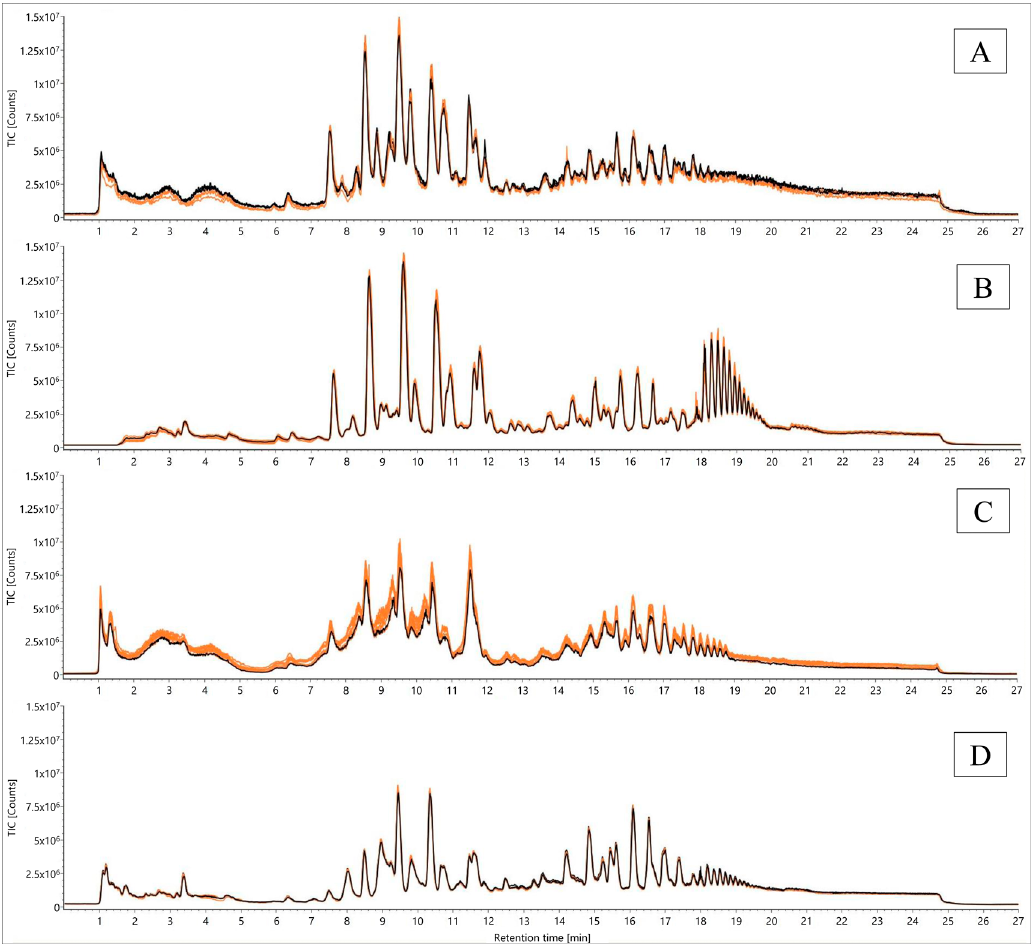
Figure 4. Comparison of TICs from a QC sample according to Folch [23] for signal stability over 2.5 days using different analysis parameters (desolvation temperature and gas flow, removal of injection peak, electrospray ionization source (ESI) probe angles): ( A ) 823.15 K, 1000 L/h, ESI probe angle position 7; ( B ) 823.15 K, 1000 L/h, ESI probe angle position 7, waste until 1.5 min; ( C ) 823.15 K, 1000 L/h, ESI probe angle position 8.5; ( D ) 703.15 K, 800 L/h, ESI probe angle position 7; first five injections (orange) versus the last five (injections 126–130, black).